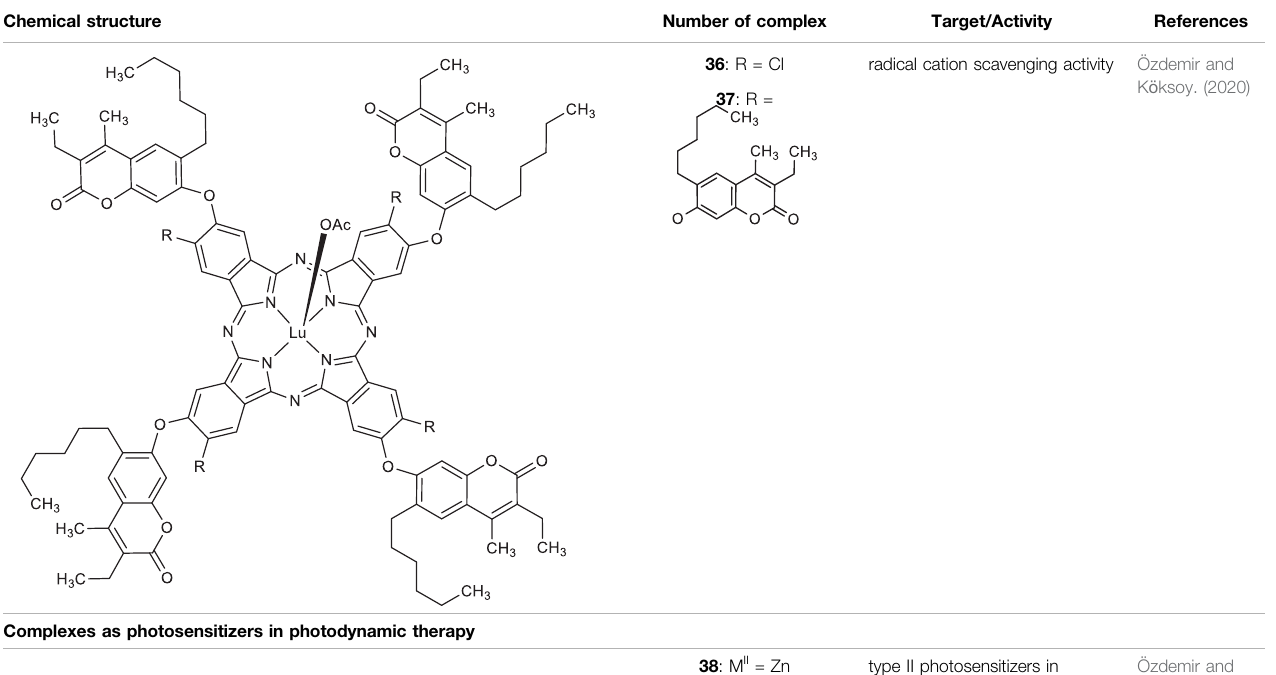
TABLE 1 | ( Continued ) Coumarin-based metal complexes with diverse biological